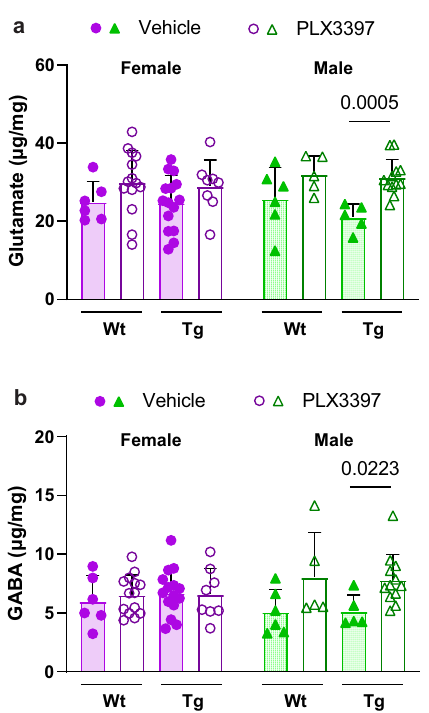
Fig. 7 | PLX dysregulates neurotransmitter levels in the brains of male Tg2541 mice. a Glutamate levels in forebrainlysates of wildtype(Wt)or Tg2541 (Tg) mice, dosed for 6 – 12 weeks with PLX3397 (275mg/kg oral) or vehicle beginning at